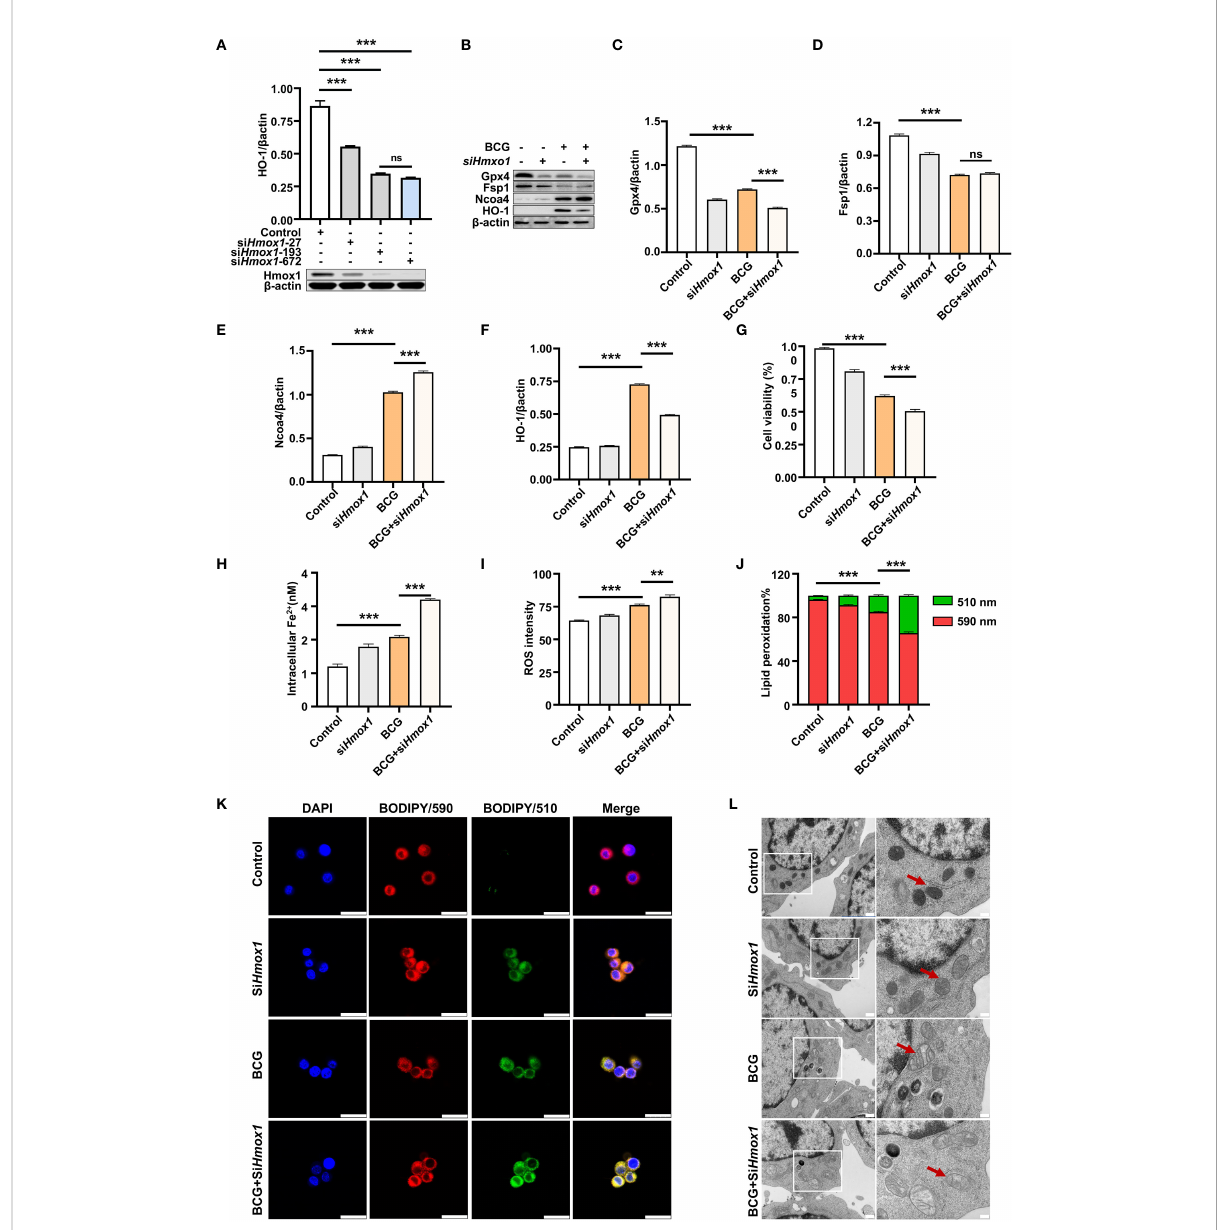
FIGURE 6 Knockdown of Hmox1 increases BCG-induced macrophage ferroptosis. (A) Representative blots of Hmox1 protein in RAW264.7 cells transfected with siRNA to murine Hmox1 gene. siRNA was transfected by Lipofectamine ™ RNAiMAX, and the protein was analyzed at 24 h post- transfection. The si- Hmox1 showed the most ef fi cient knockdown of Hmox1 and was used in subsequent experiments. (B – E) Representative blots (B) and semi-quantitative analysis of Gpx4 (C) , Fsp1 (D) , Ncoa4 (E) , and HO-1 (F) proteins of RAW264.7 cells treated with indicated conditions. The siRNA-mediated knockdown of Hmox1 ampli fi ed the inhibition of Gpx4 and Fsp1 expression in cells infected with BCG. (G – J) The viability (B) , intracellular Fe 2+ (C) , intracellular ROS (D) , and lipid peroxidation (E) of RAW264.7 macrophages treated with indicated conditions, as determined by Trypan Blue assay, iron ion probes, fl ow cytometry, and BODIPY 581/591 C11 assays, respectively. (K) Representative fl uorescence images of BODIPY 581/591 C11-labeled lipoxidation of polyunsaturated fatty acids in RAW264.7 macrophages of the indicated conditions showed the increase of BCG-induced lipoxidation in cells transfected with siRNA to Hmox1 . Cell nuclei were counterstained with DAPI. (L) Representative images of transmission electron microscopy showed mitochondrial membrane ridge breaks (arrows) in siRNA-transfected RAW264.7 and/or BCG-infected macrophages; the right panel shows the enlarged image of the boxed area in its corresponding image in the left panel. Data obtained from three independent experiments were processed using GraphPad Prism 8.0.1 software and ImageJ 1.52.a. One-way ANOVA was used to analyze the differences between groups. All values are presented as mean ± SD (**p < 0.01; ***p < 0.001; n = 3). Bars, 500 nm in the right panel and 200 nm in the left panel of K, and 25 m m in L. ns, no statistical